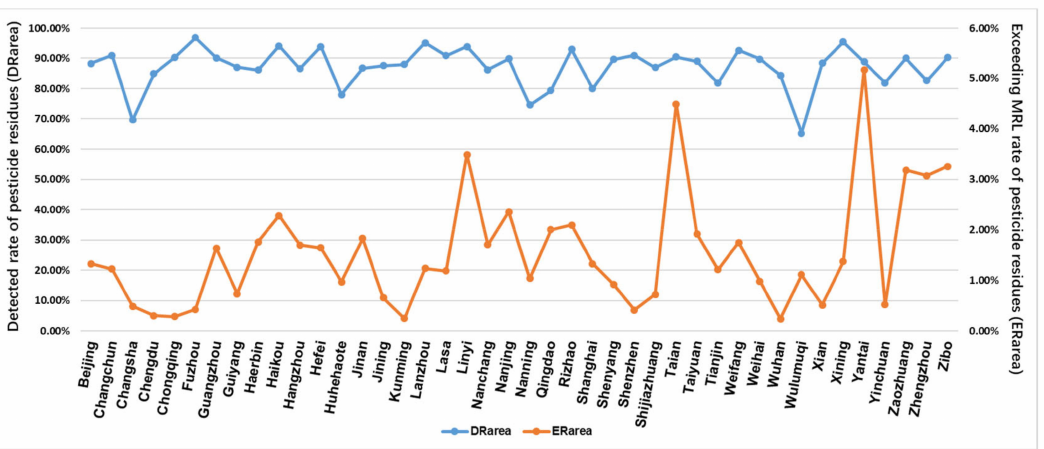
Figure 4. Detected rate of pesticide residues ( DR area ) and exceeding MRL rate of pesticide residue ( ER area ) in each sampling city.